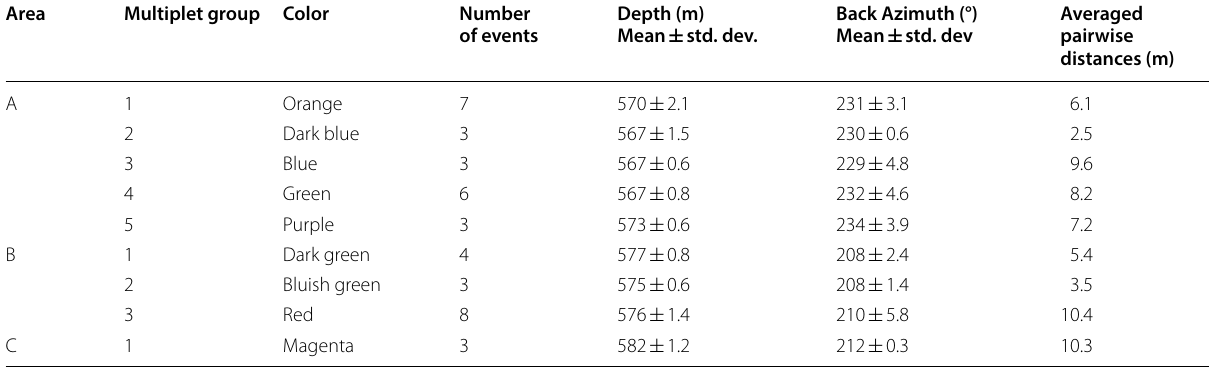
Table 1 Identified multiplet groups (excluding doublets), depths, back azimuth, and mean of geographical distances